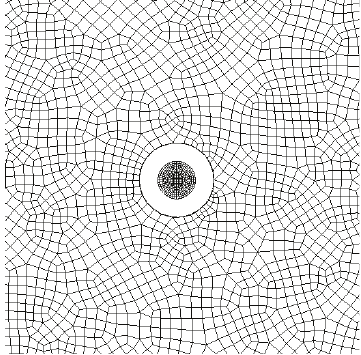
Figure 6: Mesh of the explosive and the